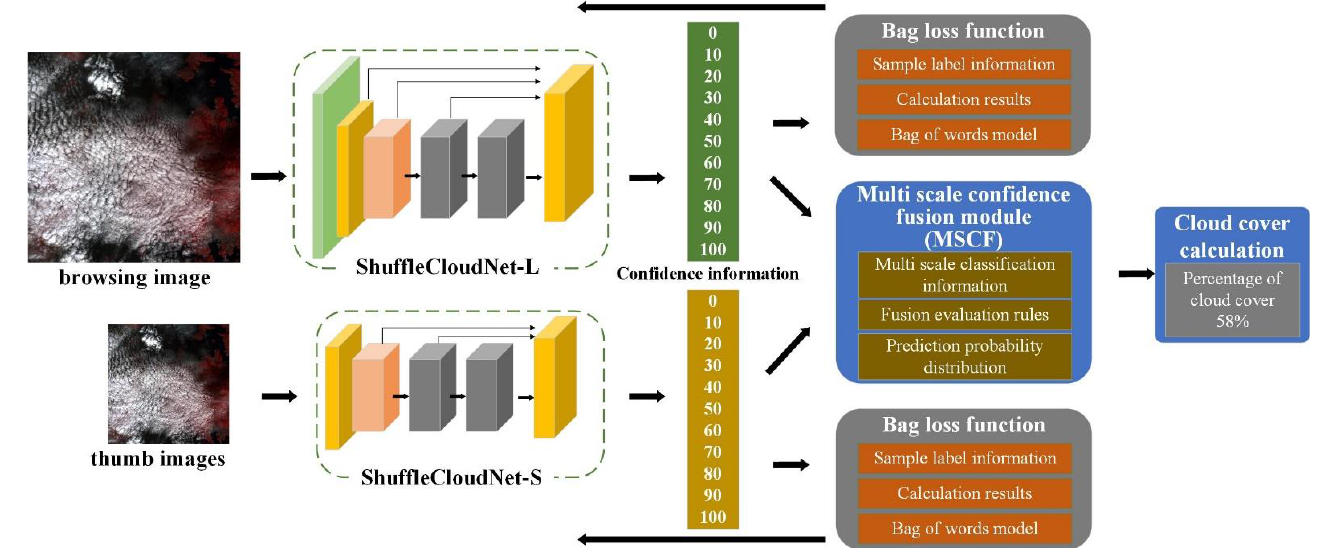
Figure 3. Structure of cloud-amount calculation based on composite neural network.